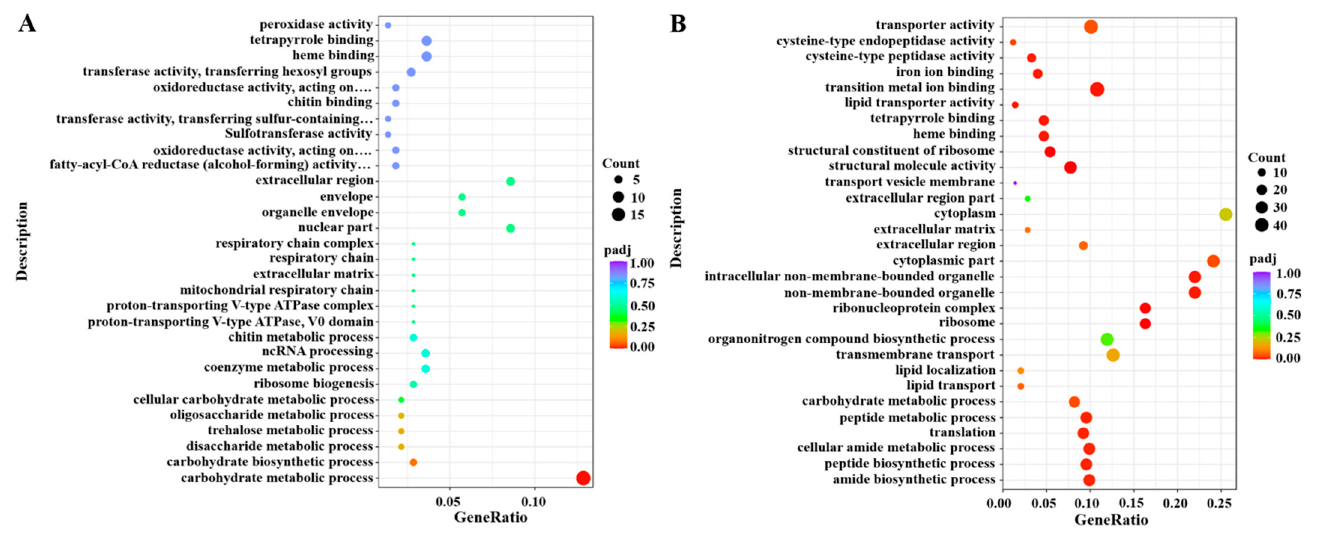
Figure 10. GO enrichment analysis of DEGs between ds DcGSK3 groups and ds GFP groups. ( A ) GO enrichment analysis of DEGs at 24 h. ( B ) GO enrichment analysis of DEGs at 48 h. The size of the bubble indicates the number of DEGs enriched to the corresponding term. The color of the bubble indicates the Q value.